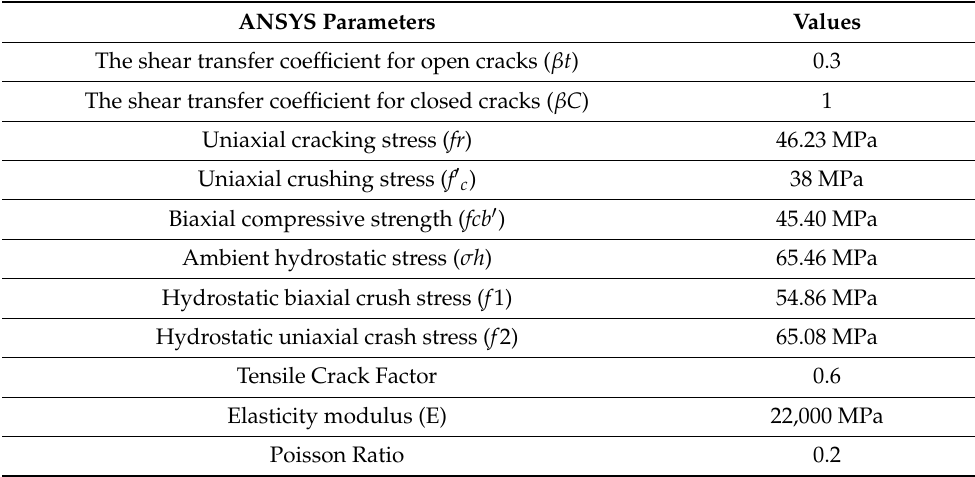
Figure 3. Comparison of stress–strain relations and FE presented in this study for a concrete cube including 20% FA with the proposed equation of Ec = 2.5 f (cid:48) c 3 5 for modified Popovics models. Table 2. Concrete failure criteria constants in ANSYS (William–Warnke).